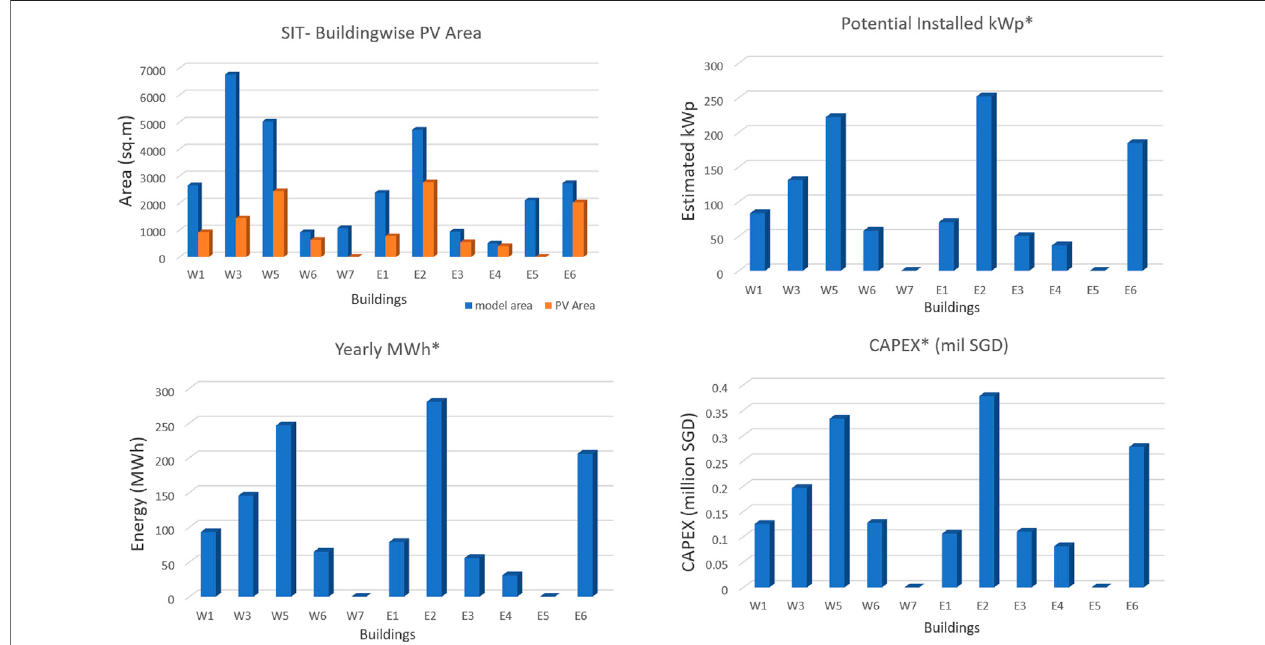
FIGURE 11 | Building-wise estimates from the PV planting